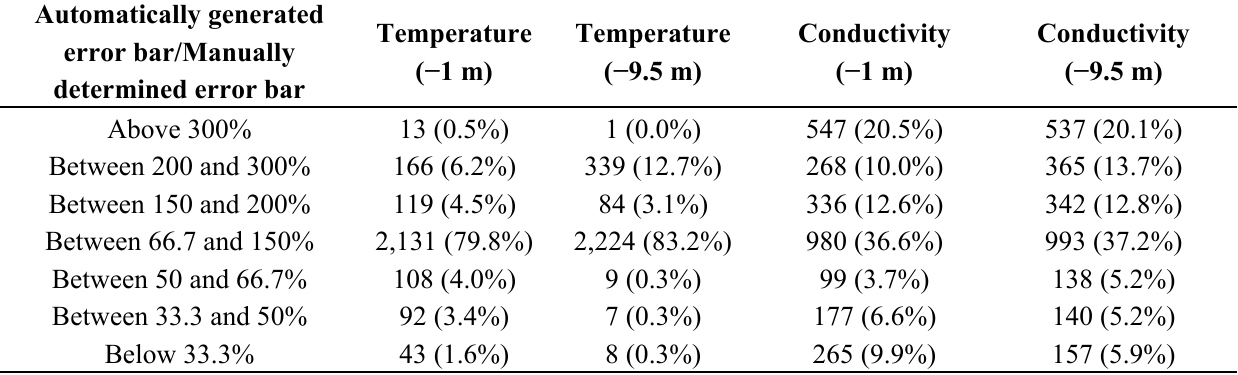
Table 3. Ratio of automatically generated to manually determined error bars (expressed